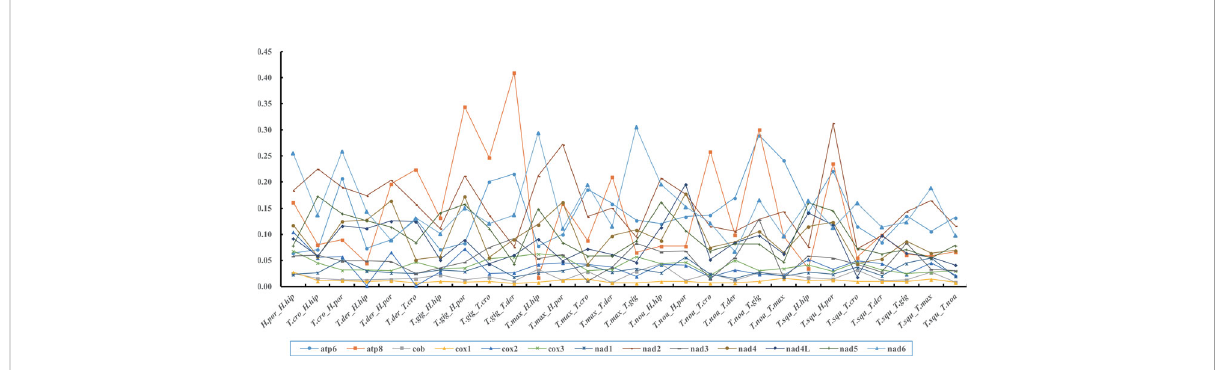
FIGURE 3 The ratio of nonsynonymous and synonymous substitutions (Ka/Ks) estimated in all 13 protein genes of eight giant clam species.